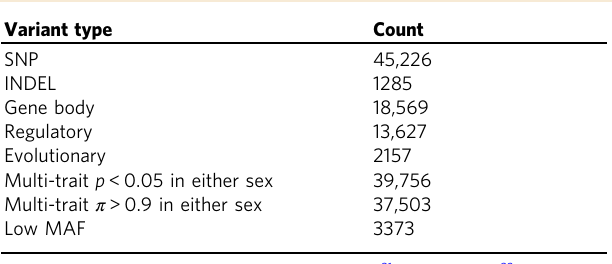
Table 1 Summary of the markers on the XT-50K genotyping